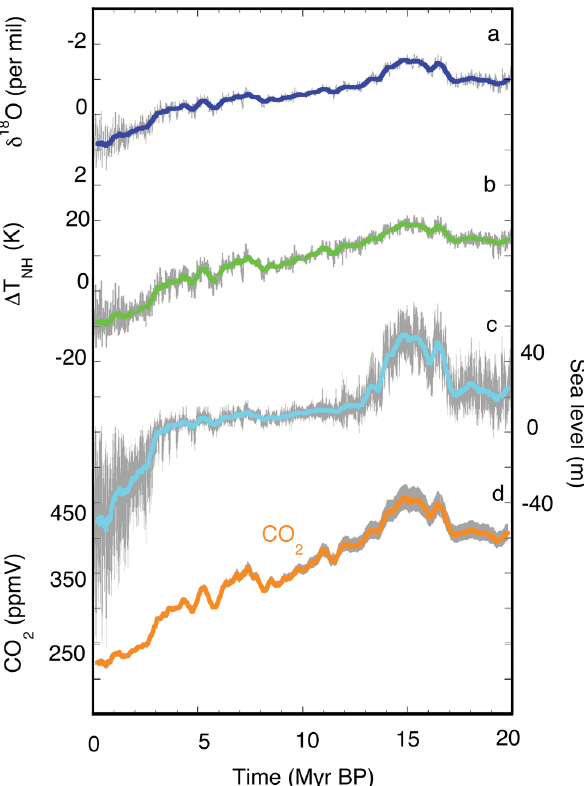
Fig. 1. Records of key climate variables over the last 20Myr. Forc- ing of the model are changes in the stacked benthic δ 18 O record with respect to preindustrial times (a, dark blue, Zachos et al., 2008). Output is a consistent record for the Northern Hemisphere temperature change with respect to pre-industrial conditions (b, green) and sea level (c, light blue). The reconstructed CO 2 record (d, orange) is obtained by inverting the relation between NH tem- peratures and CO 2 data. The δ 18 O curve is smoothed in order to clarify the gradual decrease over time. All data are available every 0.1kyr. The thick lines represent 400-kyr running mean. Grey er- ror bars indicate the standard deviation of model input and output. For CO 2 the error bar is calculated as 400-kyr running mean, for the other records it is the standard deviation on the 0.1kyr value as used in the model. Data are available as a Supplement to this